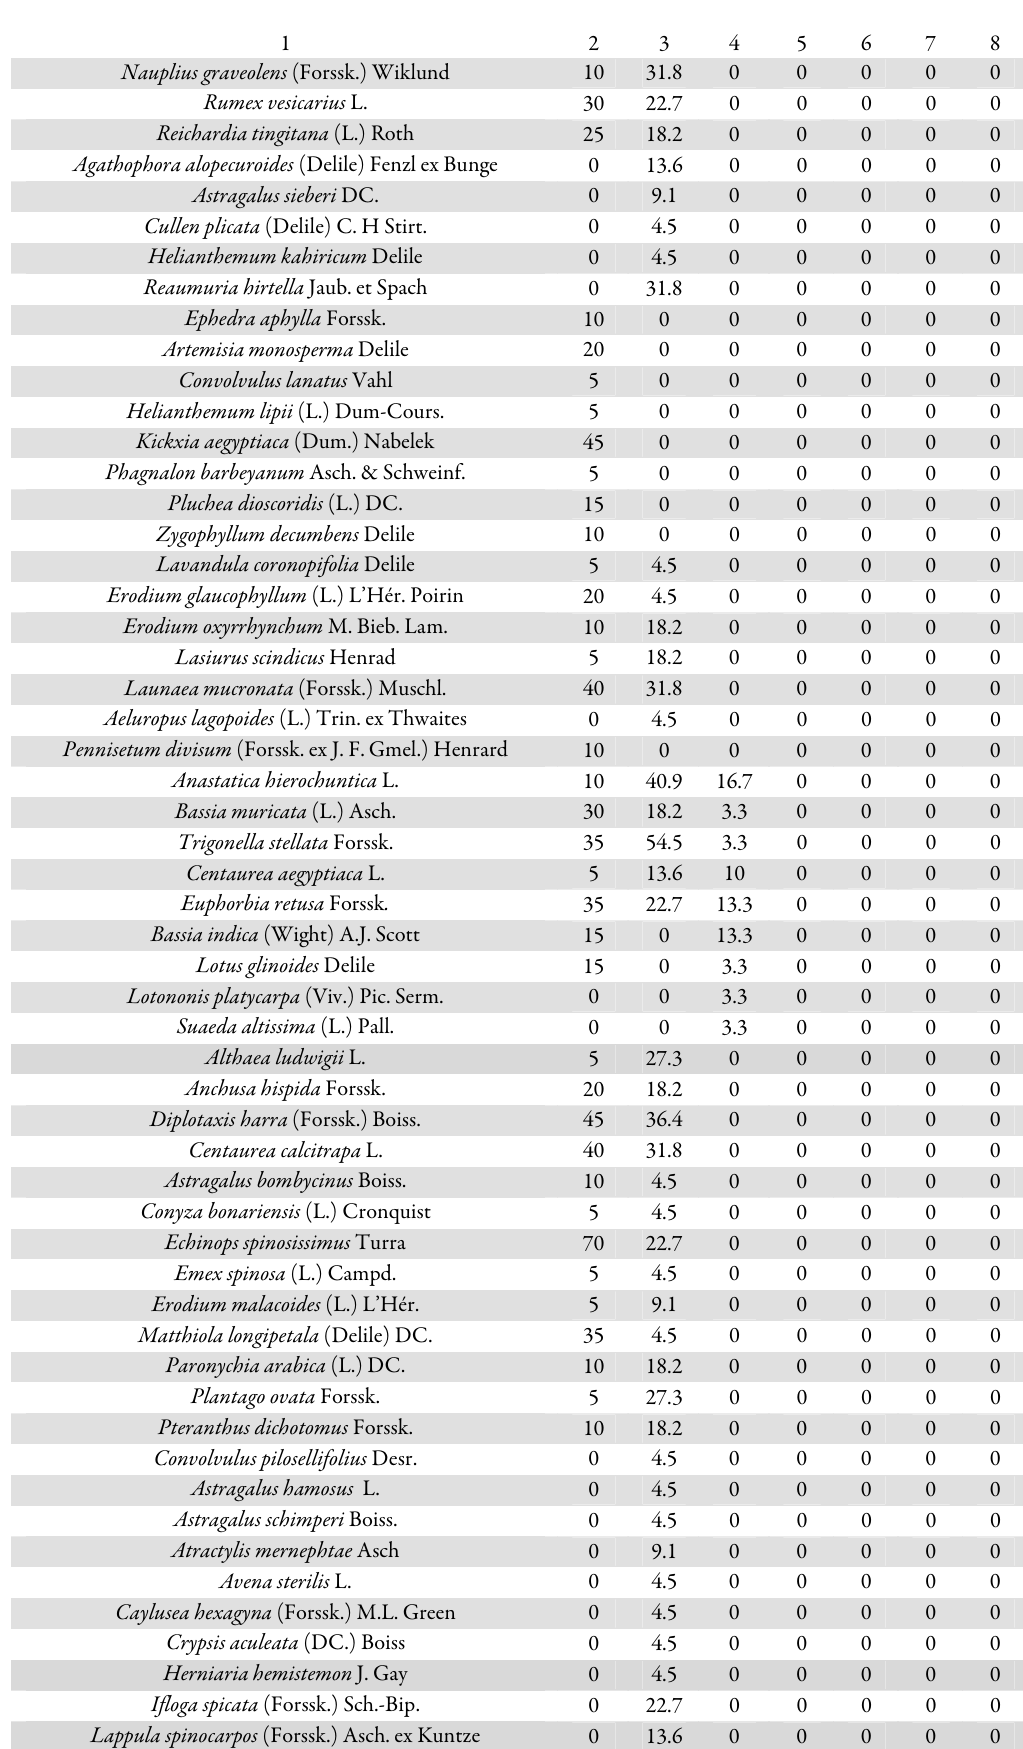
Lappula spinocarpos (Forssk.) Asch. ex